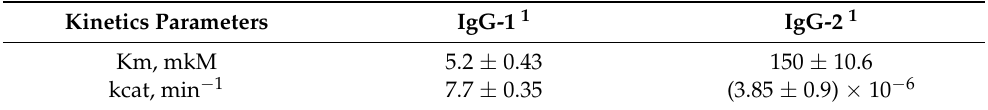
Table 2. The kinetic parameters characterizing efficiency of MBP hydrolysis by two individual IgG preparations of patients with bipolar disorder.